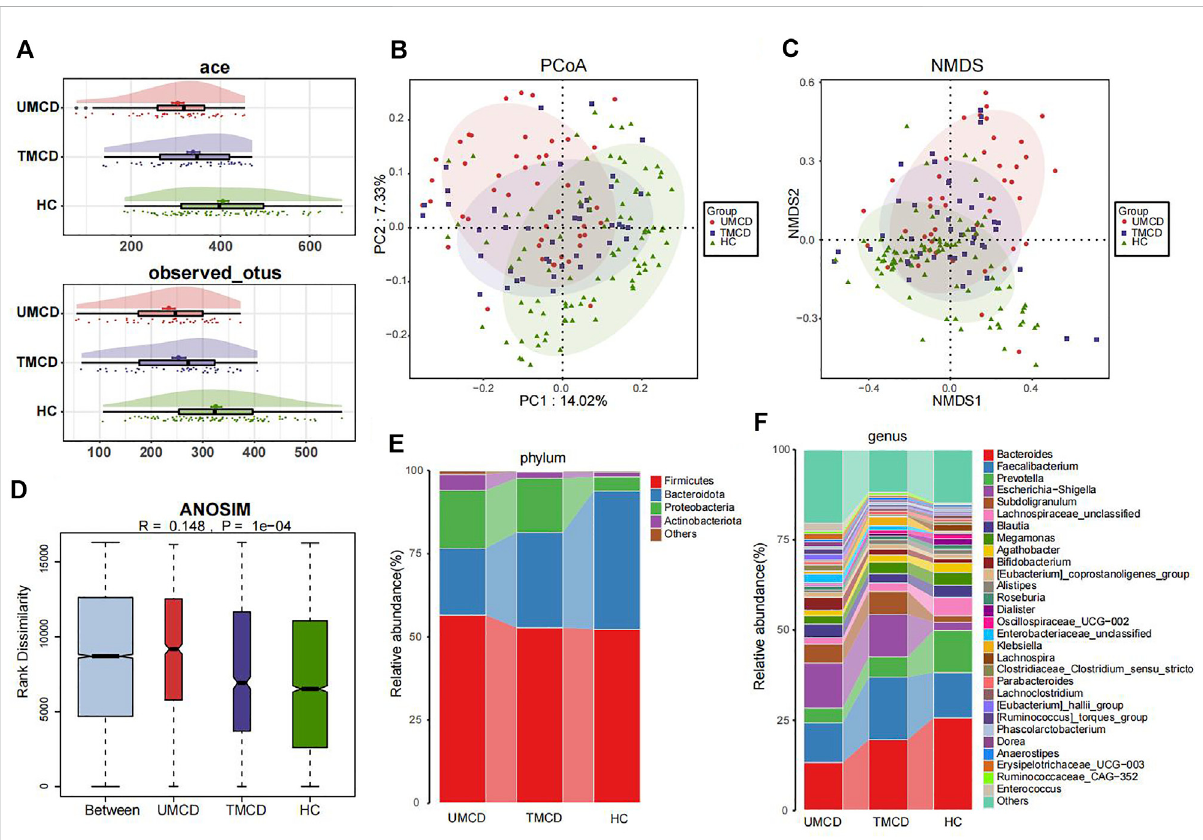
FIGURE 4 Comparison of gut microbiota compositions among UMCD ( n = 45), TMCD ( n = 45) and HC groups ( n = 91). (A) The ace indexes and observed OTUs had no difference in UMCDs and TMCDs, and both of them were lower than those in HCs (Ace index: UMCD vs. HC, p < 0.001, TMCD vs. HC, p < 0.01;observedOTUs,UMCDvs.HC, p < 0.001,TMCDvs.HC, p < 0.001). (B) PCoAdiagramshowedthattheweightedUniFracdistancegotsimilar toHCsaftertreatmentinpatientswithMCD. (C)